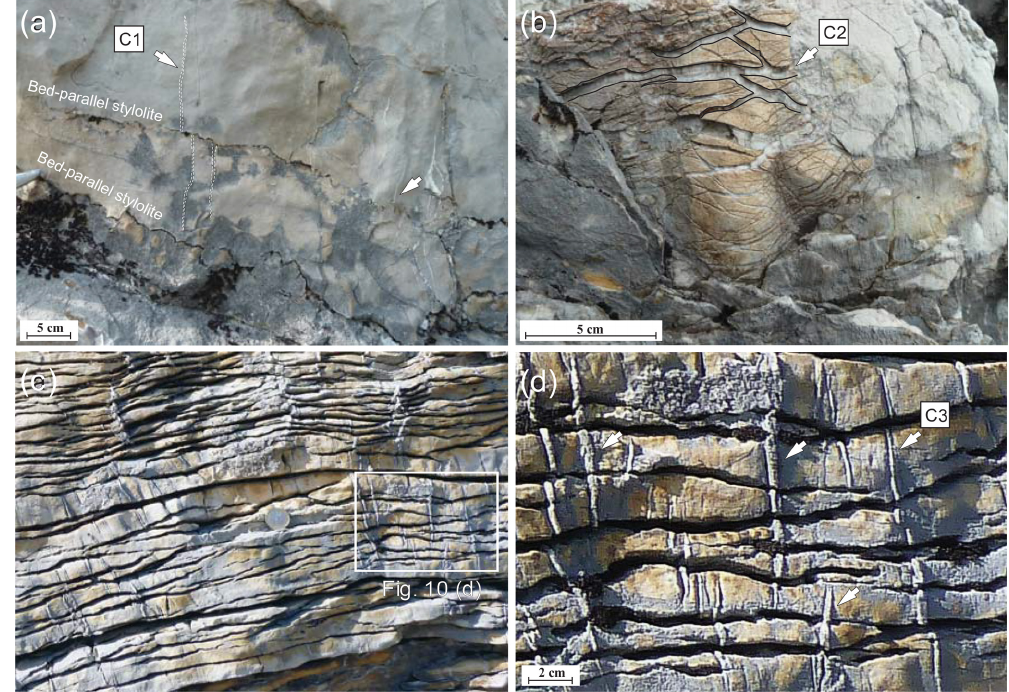
Figure 10. Field photographs showing the major calcite vein settings observed in Montagna dei Fiori. (a) Cross-sectional view of bed-normal calcite vein 1 (C1) abutting bed-parallel stylolites in folded beds of the Calcare Massiccio Formation. (b) Plan view of the calcite vein 2 (C2) intensely affecting the deformed Scaglia (Rossa) Formation. (c, d) Cross-sectional view of the Scaglia Formation intensely affected by pressure solution seams of tectonic origin crossed over by populations of bed-perpendicular calcite veins (C3) in en echelon extensional arrays. Table 1. Stable carbon and oxygen isotopes, 87 Sr / 86 Sr ratios, and fluid inclusion microthermometry data (not pressure corrected) of host rocks and diagenetic phases in the Montagna dei Fiori Anticline. Stable carbon and oxygen isotopes values are expressed in ‰ V-PDB and salinity values in eq.wt%NaCl. Stable isotopes Sr isotopes Fluid inclusion